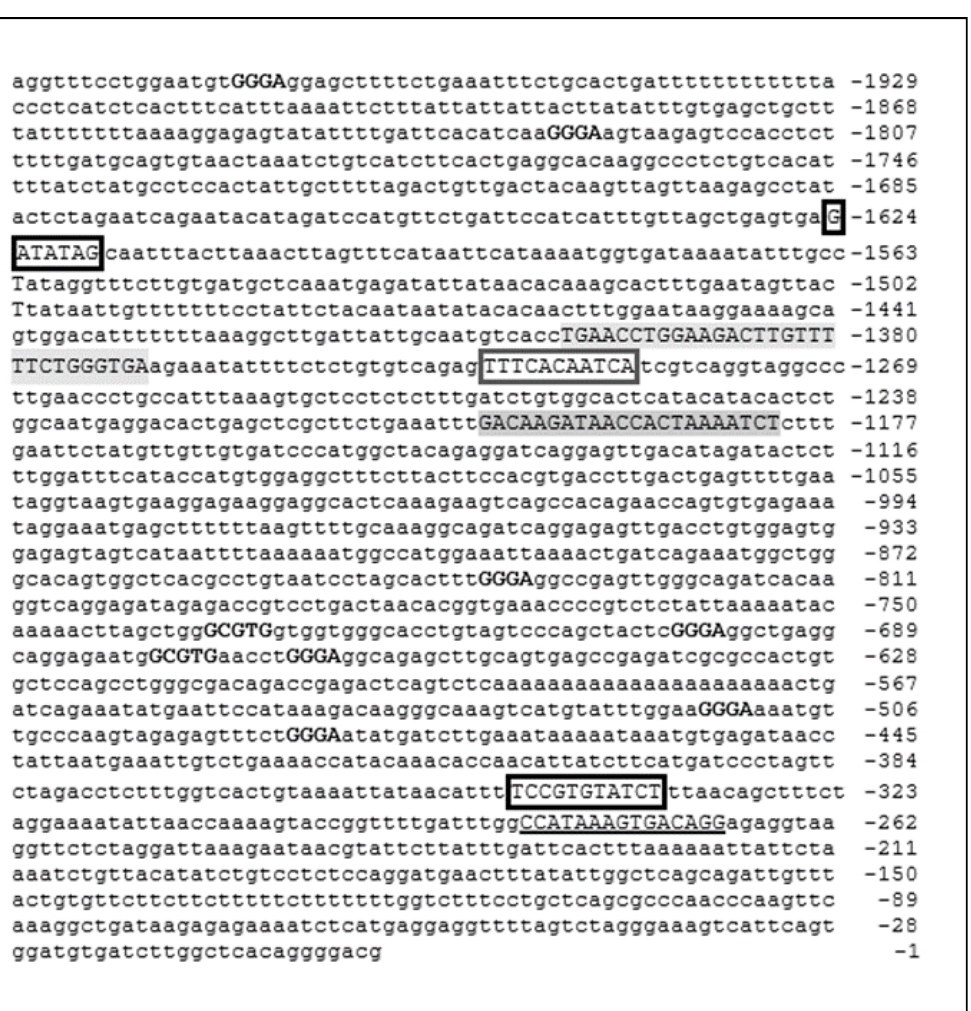
Figure 5. DNA sequence of the promoter region of the ACE-2 gene. Numbers indicate the position of the nucleotide upstream of the starting site for protein production. Core XRE (GCGTG) and NC-XRE (GGGA) motifs are shown in bold. Additional regulative consensus motifs are showed as follows: TATA box (underlined); GATA motifs (black boxed); STAT / FOXA / FOXO / Ets / GR / p53 motif (light grey); GATA / HNF1 motif (dark grey); C / EBP motif (grey boxed).